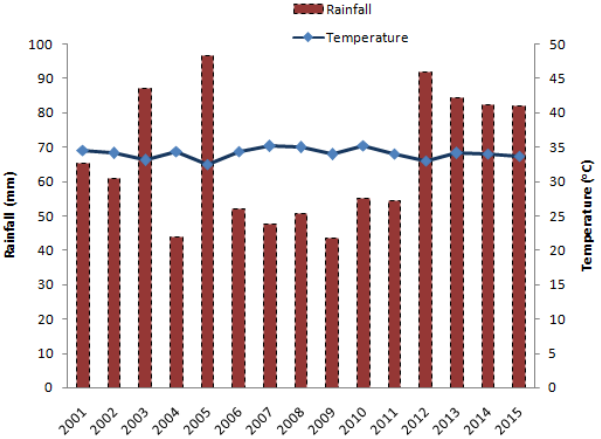
Figure 2. Climate diagram for one of the meteorological stations (Nallampalli 12.34 ◦ N, 77.88 ◦ E) of the study region at 349m ele- vation – rainfall vs. temperature for the crop-growing period (June– October) from 2001 to 2015. The significant drought period was observed from 2006 to 2011, followed by adequate rainfall distri- bution (2012–2015) which is appropriate for crop production. If the degraded land (2006–2011) is not renewed or regenerated after re- ceiving sufficient rainfall, which occurred from 2012 to 2015, then the situation is termed as desertification, otherwise it is just seen as degraded